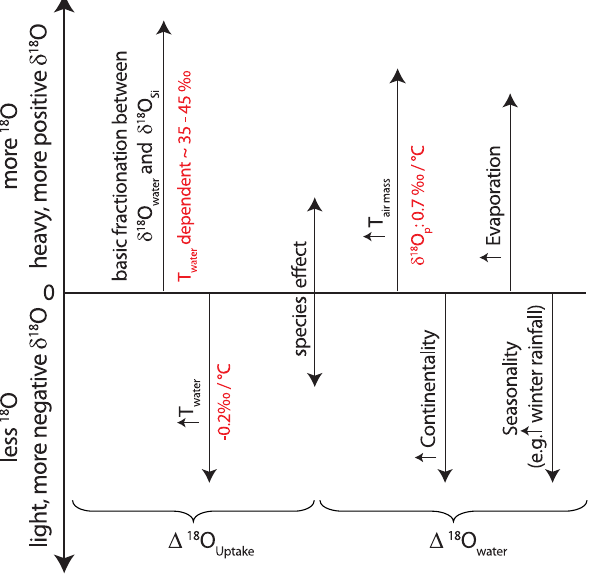
Fig. 5. δ 18 O diatom controls in the lacustrine environment. 1 18 O uptake arrows mark direct fractionation mechanisms between δ 18 O diatom and δ 18 O lake water while 1 18 O water arrows indicate at- mospheric or hydrological processes influencing the δ 18 O lake water and thus, indirect mechanisms on δ 18 O diatom . Small up pointing arrows indicate an increase of the respective